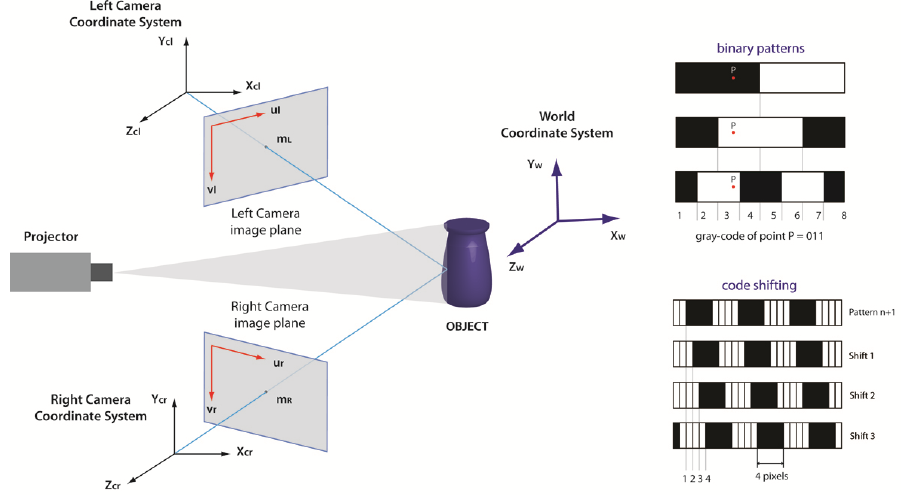
Figure 3. ( Left ): triangulation of a stereo configuration composed by two cameras and a projector. The points m and m are the projection of the same 3D point object w on the L R image planes of the two cameras. ( Right ): examples of binary patterns and code